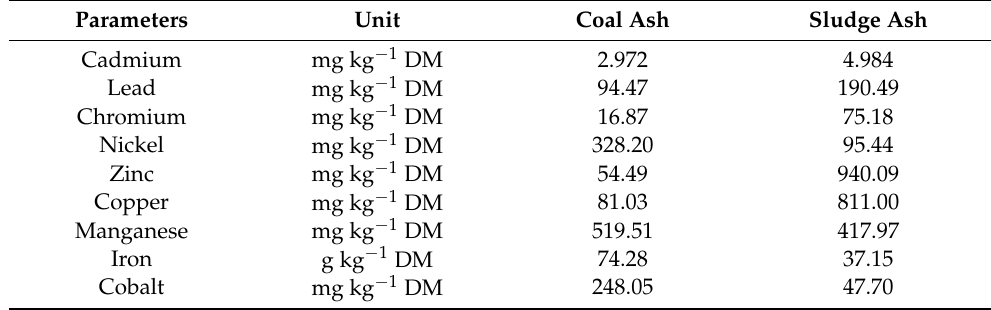
Table 5. Trace element content in coal ash waste and sludge ash waste applied in the experiment (mg kg − 1